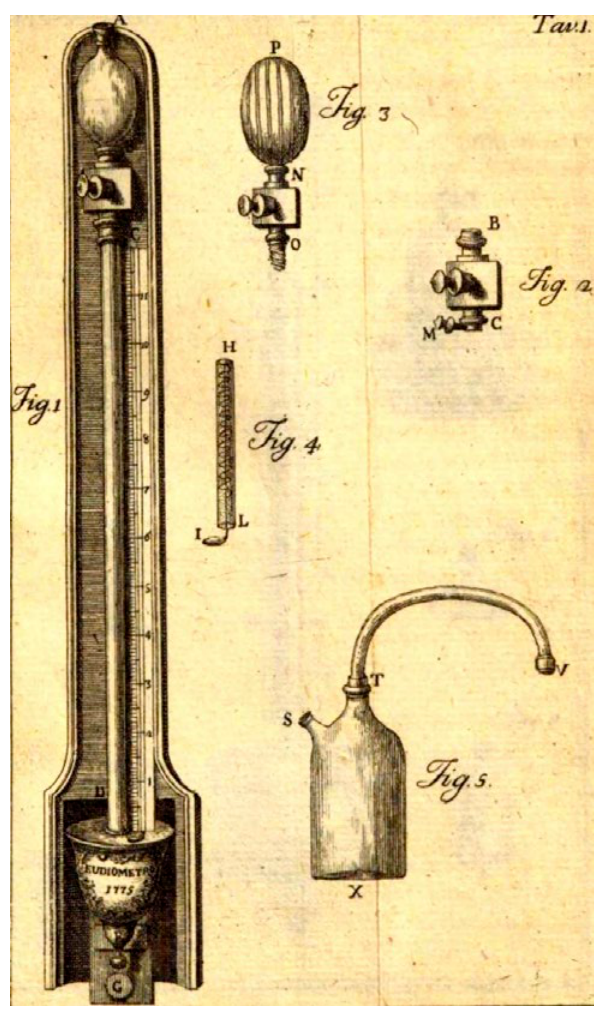
Figure 2. Landriani’s eudiometer. From Marsilio Landriani, Ricerche fisiche intorno alla salubrità dell’aria (Milano, 1775), plate